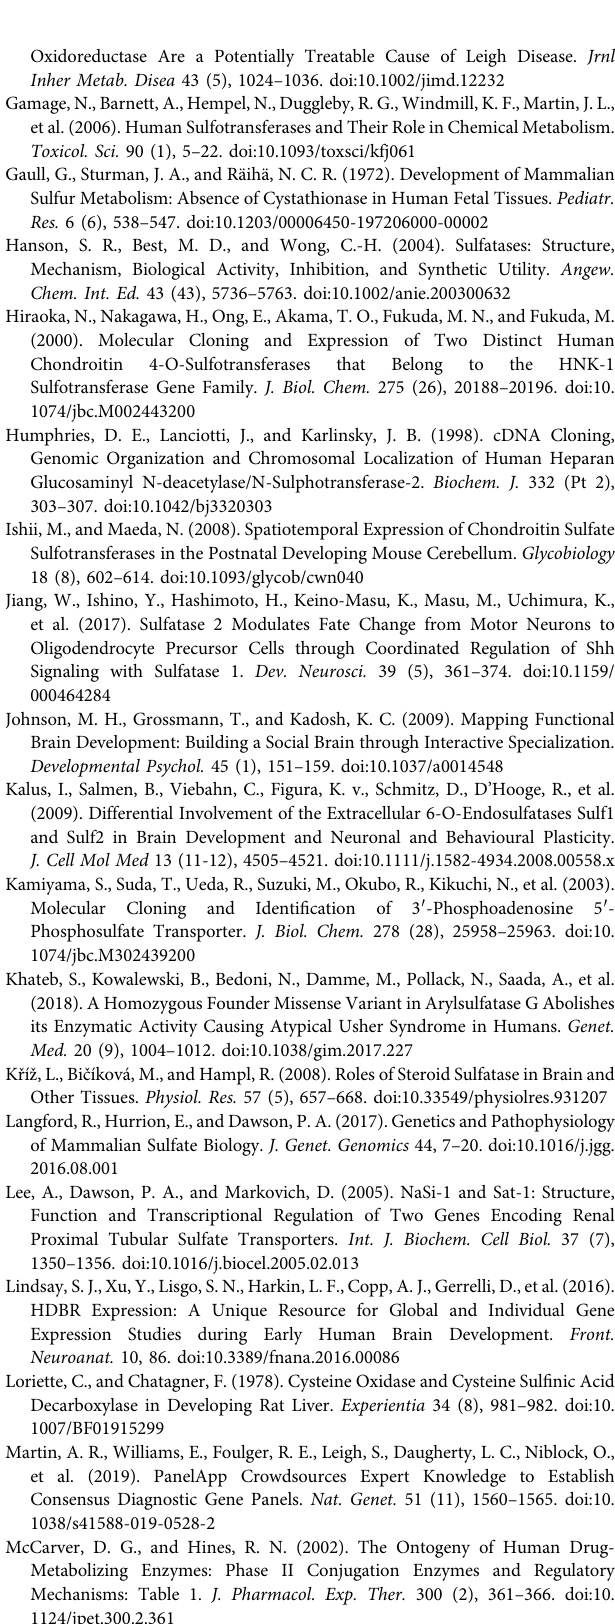
Mechanisms: Table 1. J. Pharmacol. Exp. Ther. 300 (2), 361 – 366. doi:10.